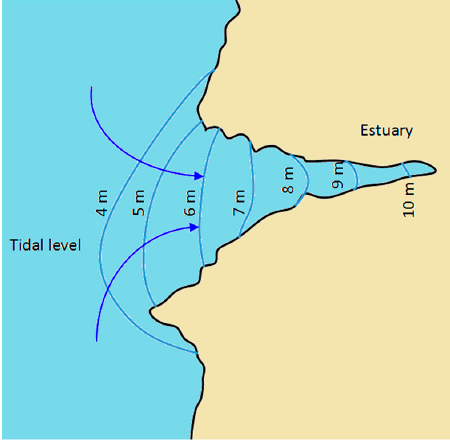
Figure 7. Effect of funnelling in an Estuary: the water levels inside the estuary rise due to the force of incoming water.